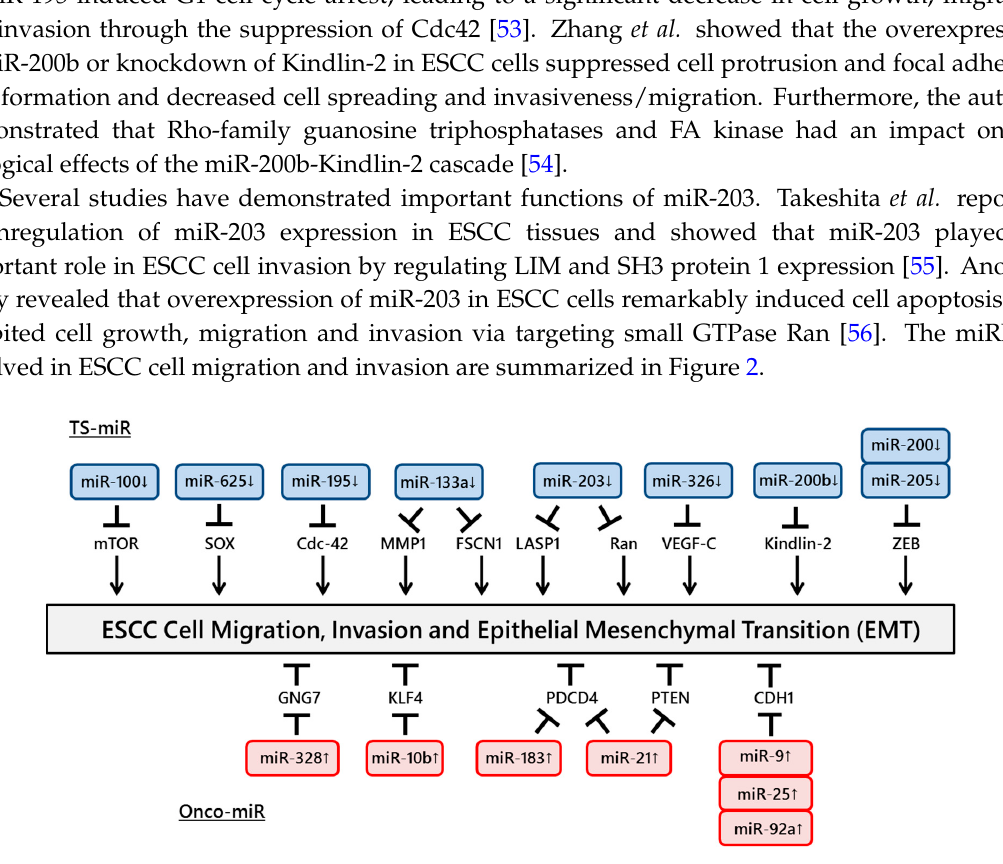
Figure 2. ncRNAs involved in ESCC cell migration and invasion. A number of ncRNAs regulate ESCC cell migration and invasion through targeting tumor suppressor genes or oncogenes.